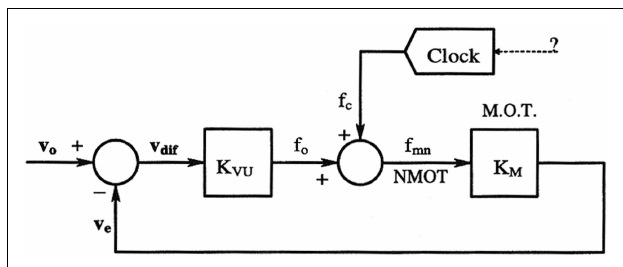
FIGURE 3 | Feedback-loop speed control system possibly involved in MOT activity .The closed-loop would reduce the slip speed between the target motion ( v o ) and the angular speed of the visual axes ( v e ). In this model, the periodic response of the muscle is seen to be triggered by an external signal acting as an input disturbance on the visual feedback loop. K vu and K m are two pure gains, whereas the clock block can be regarded as a periodic signal generator. Reproduced with permission from Northrop